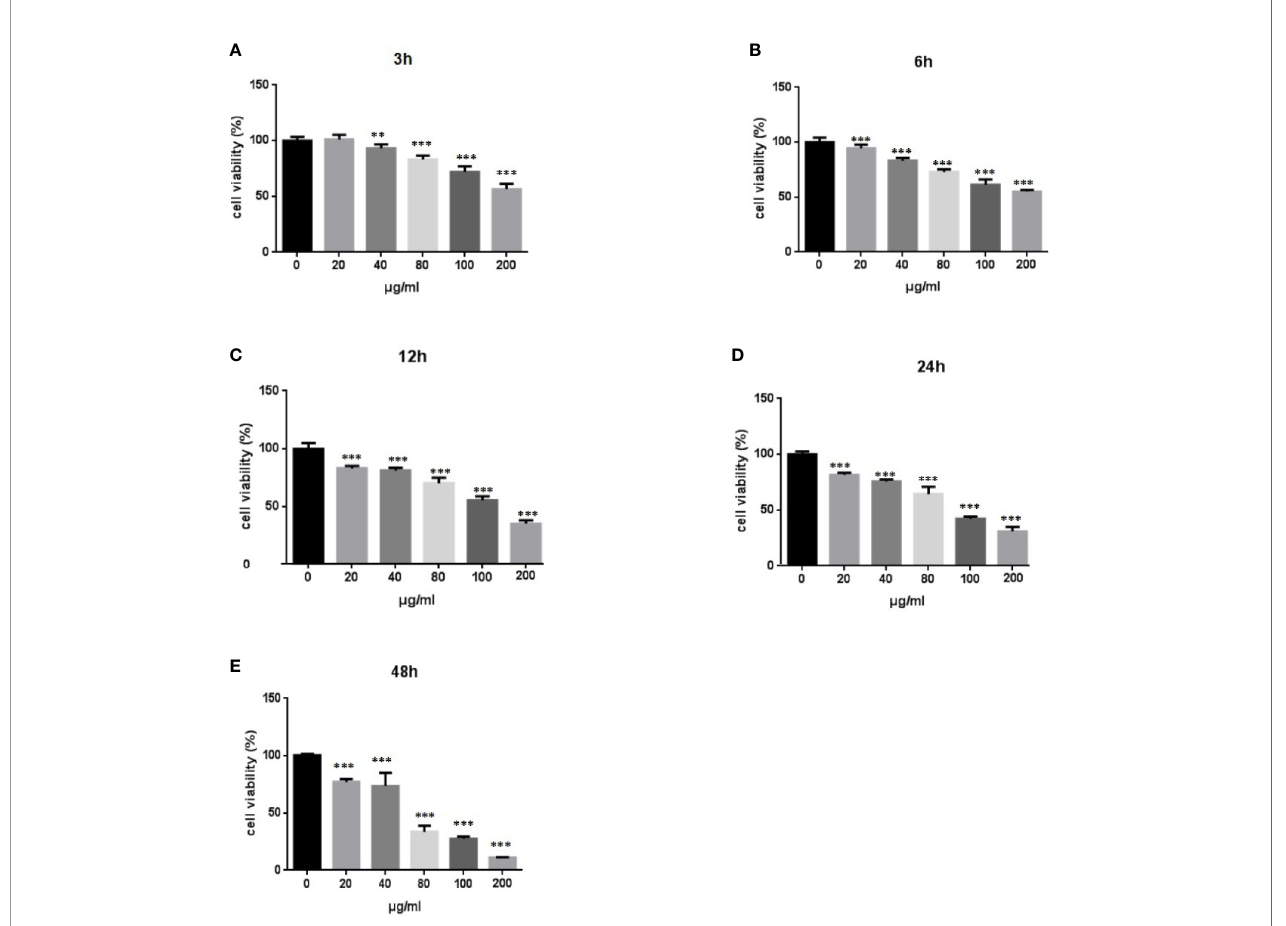
FIGURE 1 | Effects of LPS at concentrations of 0 – 150 m g/ml on A549 cell viability. MTT assays show time- and-dose dependent A549 cell proliferation response to LPS treatment (A – E) . *p < 0.05, **p < 0.01, and ***p < 0.001 compared with the control group. Graphs show the mean ± SD of triplicate wells and represent three independent